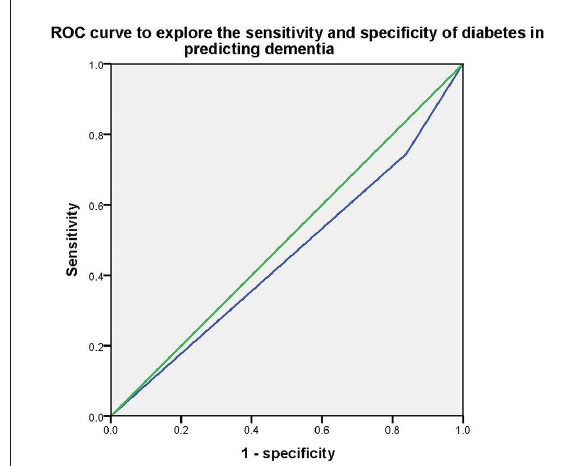
FIGURE1 ROC curve to explore the sensitivity and specificity of diabetes in predicting